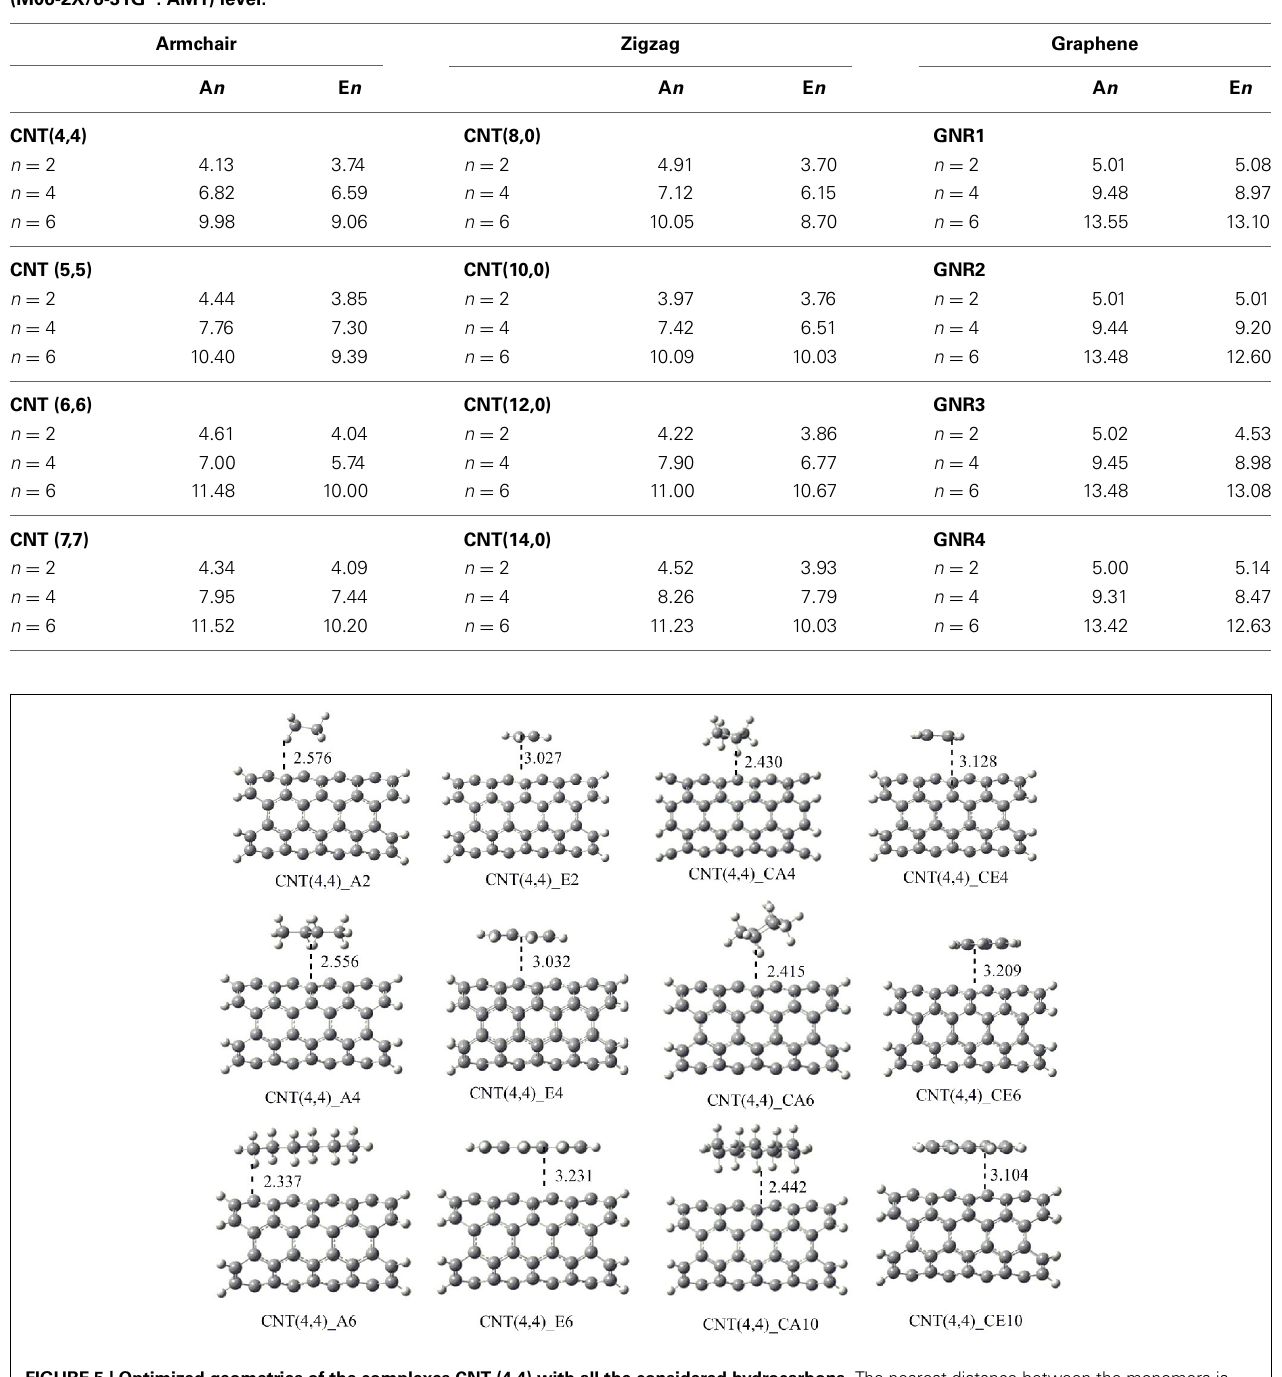
FIGURE 5 | Optimized geometries of the complexes CNT (4,4) with all the considered hydrocarbons. The nearest distance between the monomers is given in